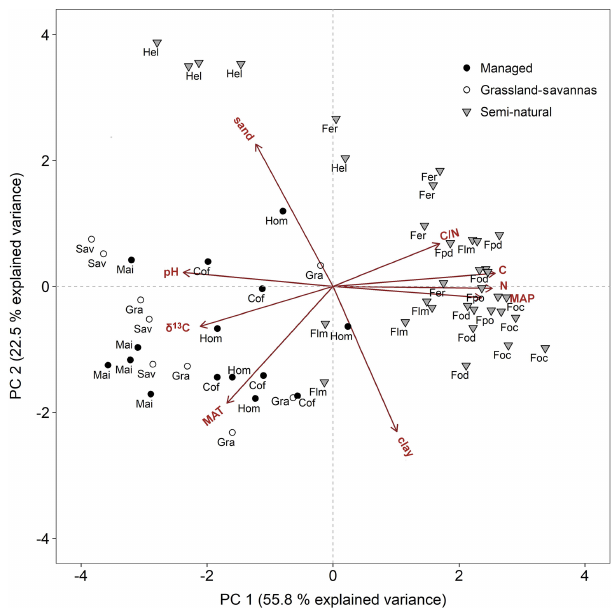
Figure 5. Principal component analysis bi-plot for soil and climate variables potentially controlling soil δ 15 N. Symbols are as per all previous figures. Acronyms are as per Table 1. C / N: soil C / N ratio,